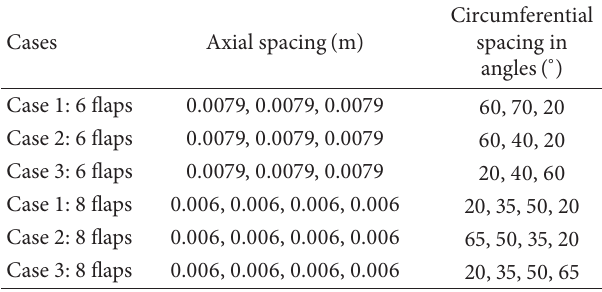
Table 1: Geometric parameters used for various microflap configu-